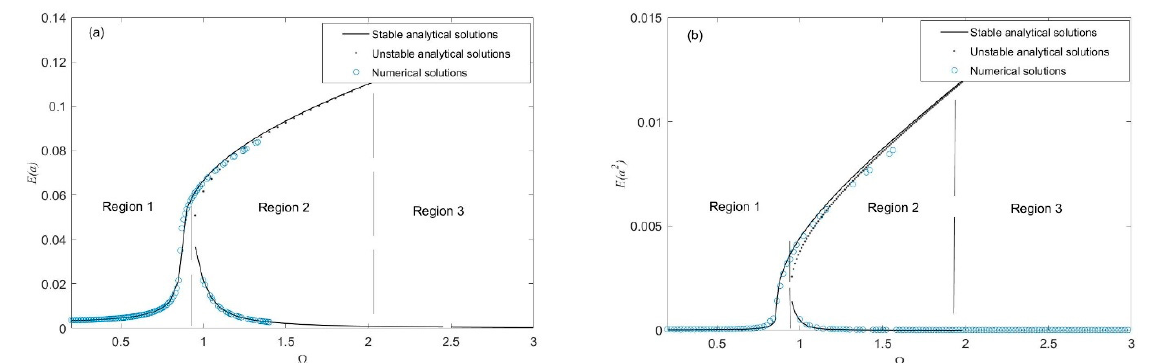
Figure 5. Frequency–amplitude responses of the stochastic SMA oscillator system (11) with the fixed system parameters 𝜁 = 0.1 , 𝛽 = −1.3 × 10 (cid:2871) , 𝛾 = 4.7 × 10 (cid:2873) , ℎ = 0.06 , 𝑓 = 0.03 , 𝜃 = 1.9 . ( a ) First-order moment of amplitude 𝑎 ; ( b ) second- order moment of amplitude 𝑎 : “-” stable analytical solutions, “.”unstable analytical solutions, “o “numerical solutions.